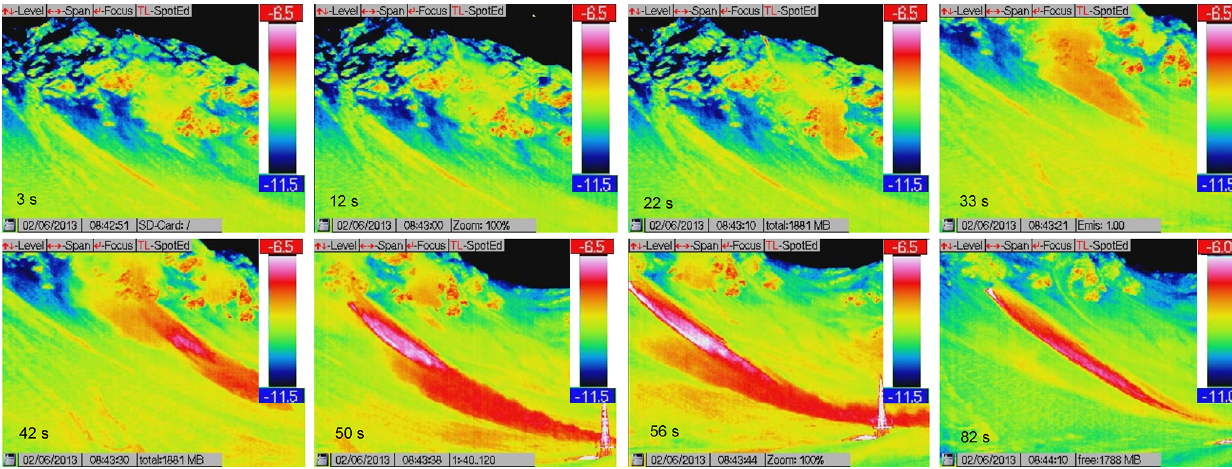
Figure 5. Screenshot of IRT camera videos for avalanche #2. The first picture was taken 3s after the avalanche released. Note that the temperature scale was changed by 0.5 ◦ C for the last shown image